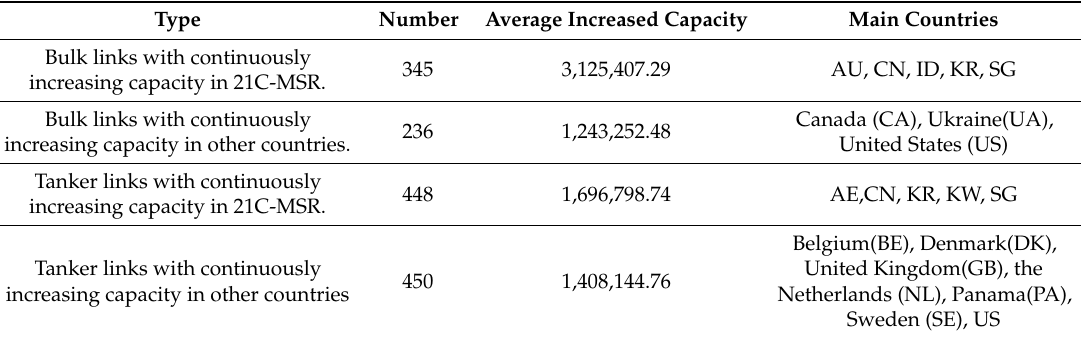
Table 3. Links with continuously increasing capacity.